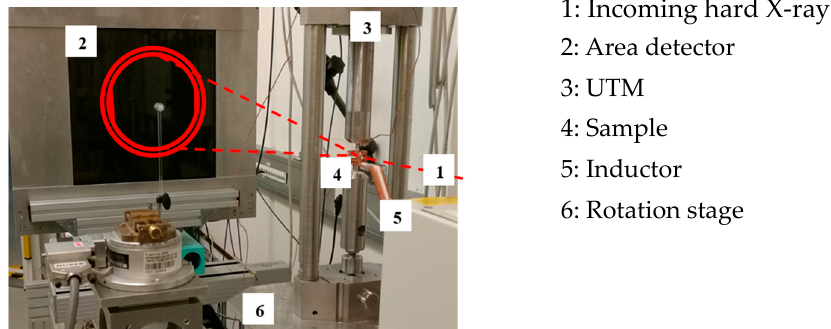
Figure 1. Beamline setup for texture measurement at HEMS P07B. Incoming hard X-ray and diffracted beam is marked with red line and circles.